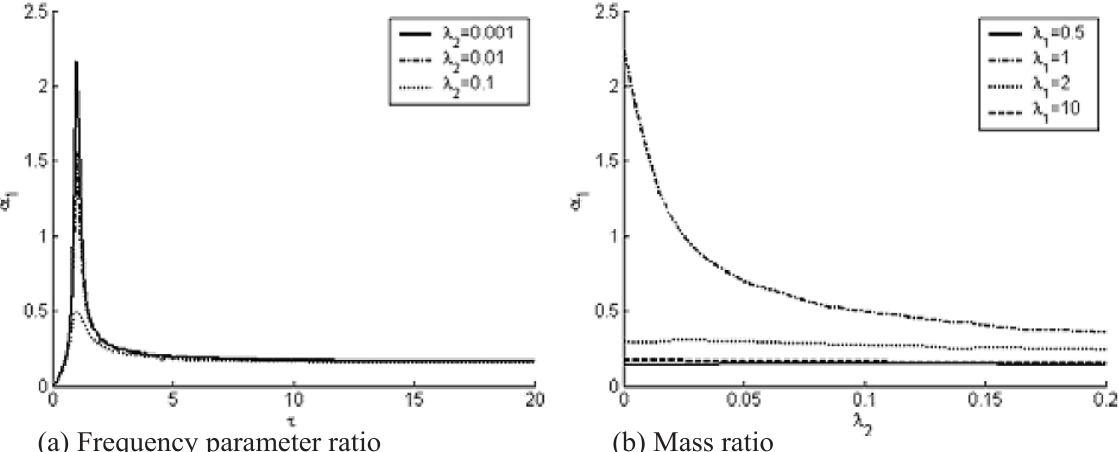
(cid:1)(cid:1) = 0 . 5 , 0 m